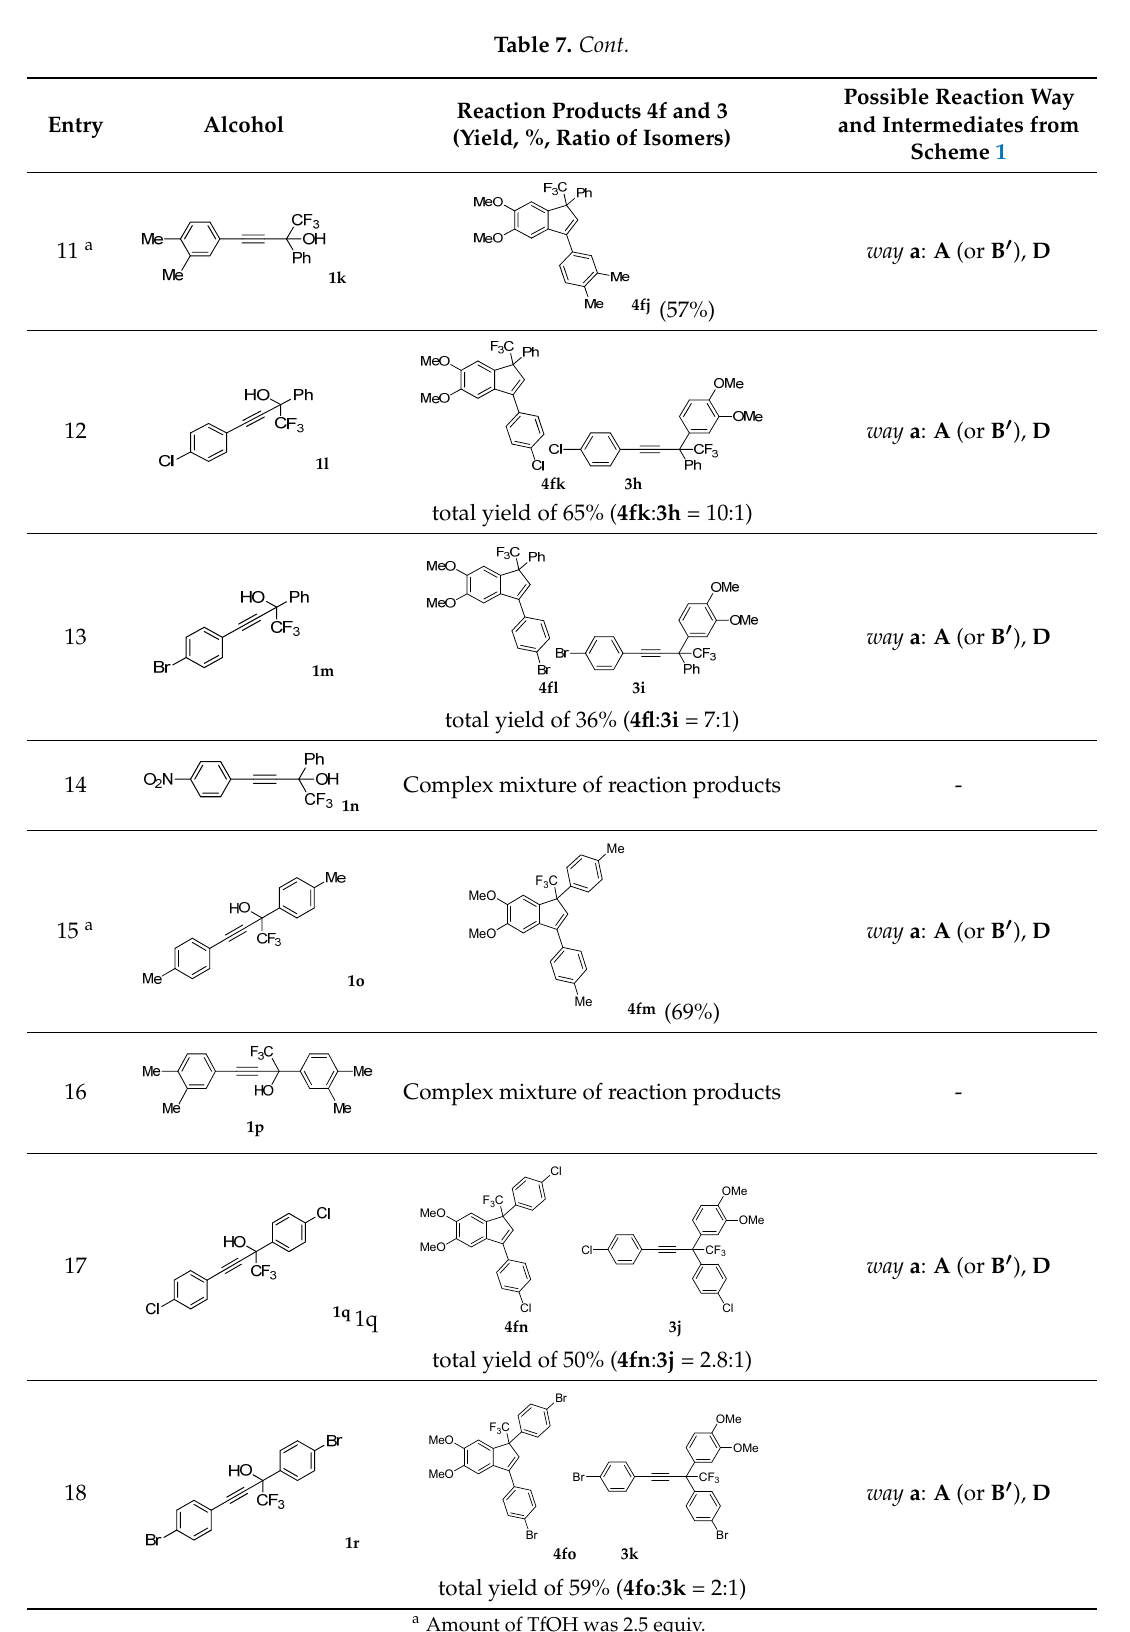
total yield of 50% ( 4fn : 3j = 2.8:1)